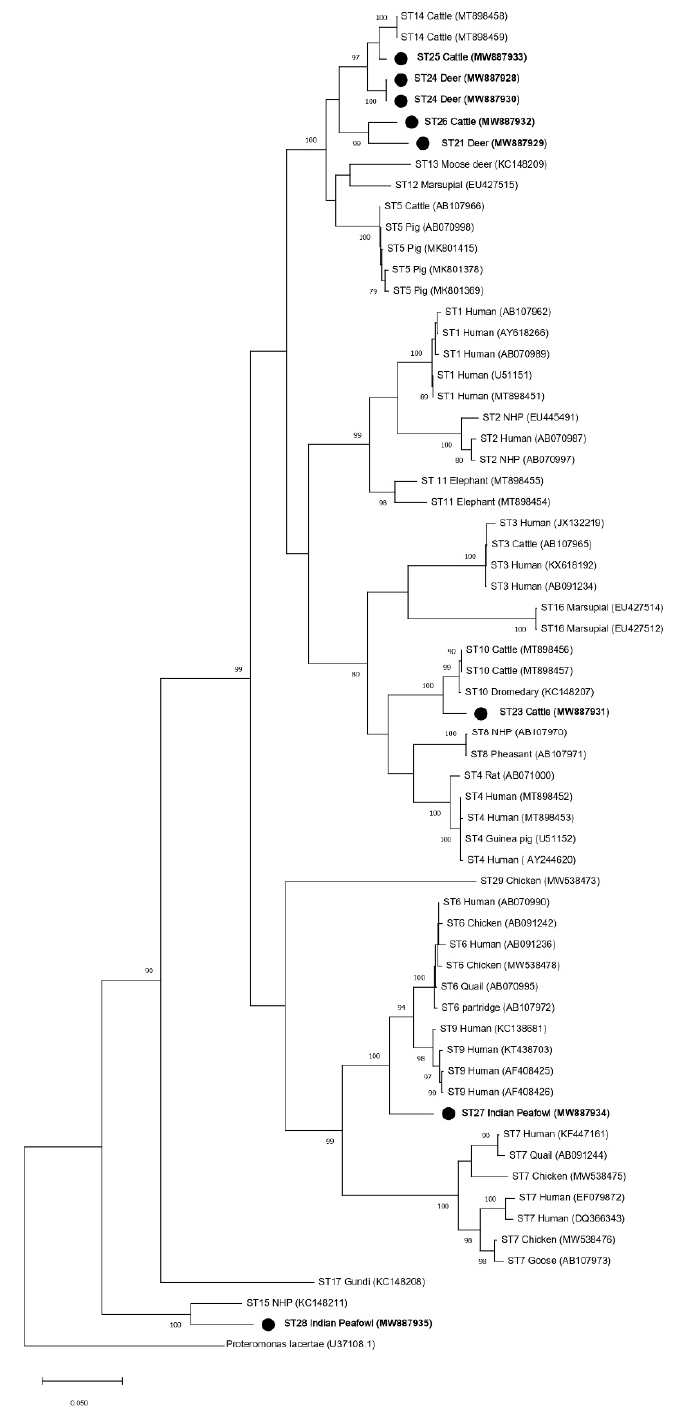
Figure 6. Phylogenetic relationships among Blastocystis partial SSU rRNA gene sequences of the Santin region generated in the present study (represented with a black filled circle) and representative reference sequences of the accepted subtypes (Table 2). Proteromonas lacertae was used as outgroup taxon to root the tree. Analysis was conducted by a maximum likelihood method. Genetic distances were calculated using the Kimura two-parameter model. This analysis involved 64 nucleotide sequences, and there were a total of 568 positions in the final dataset. Bootstrap values lower than 75% are not displayed.